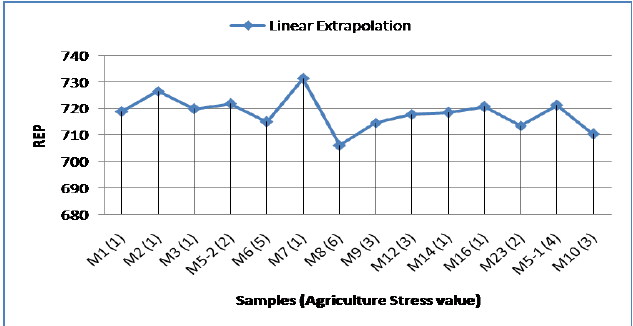
Figure 6: REP for mulberry plants using Linear Extrapolation method